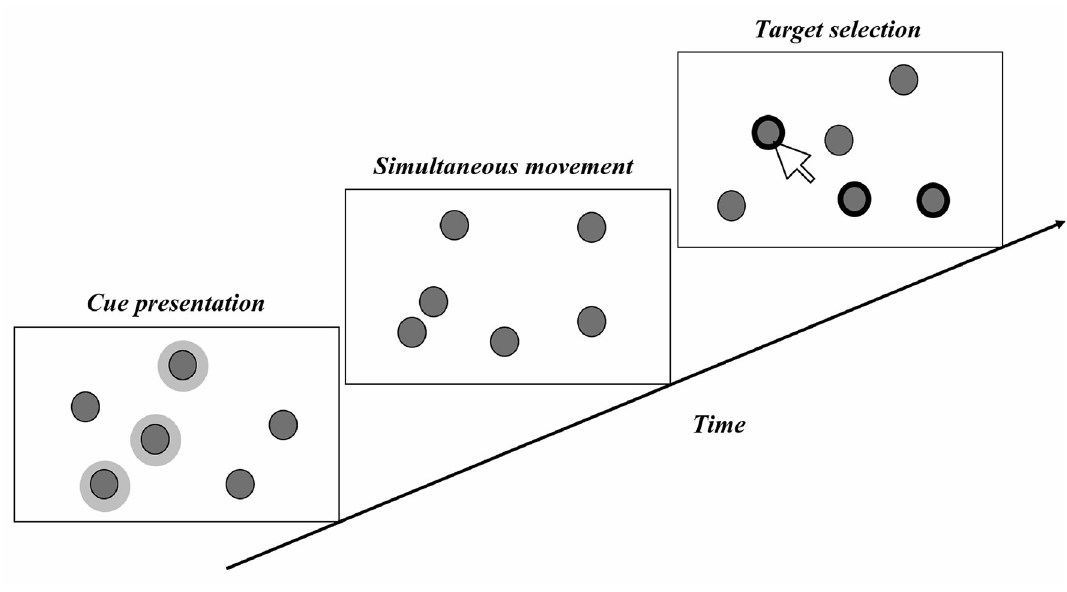
Fig 2. The Basic MTT